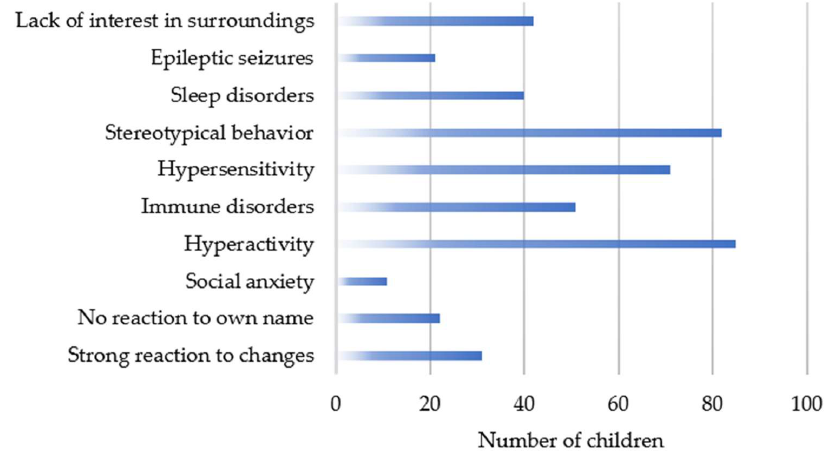
Figure 3. Observed types of behaviour in the study group of children with ASD. In more than half of the cases, with the increase in the level of HVA, hyperactivity, stereotypical behaviour and immunity disorders increased. In more than half of the cases, with the increasing level of VMA, hyperactivity and stereotypical behaviour increased.